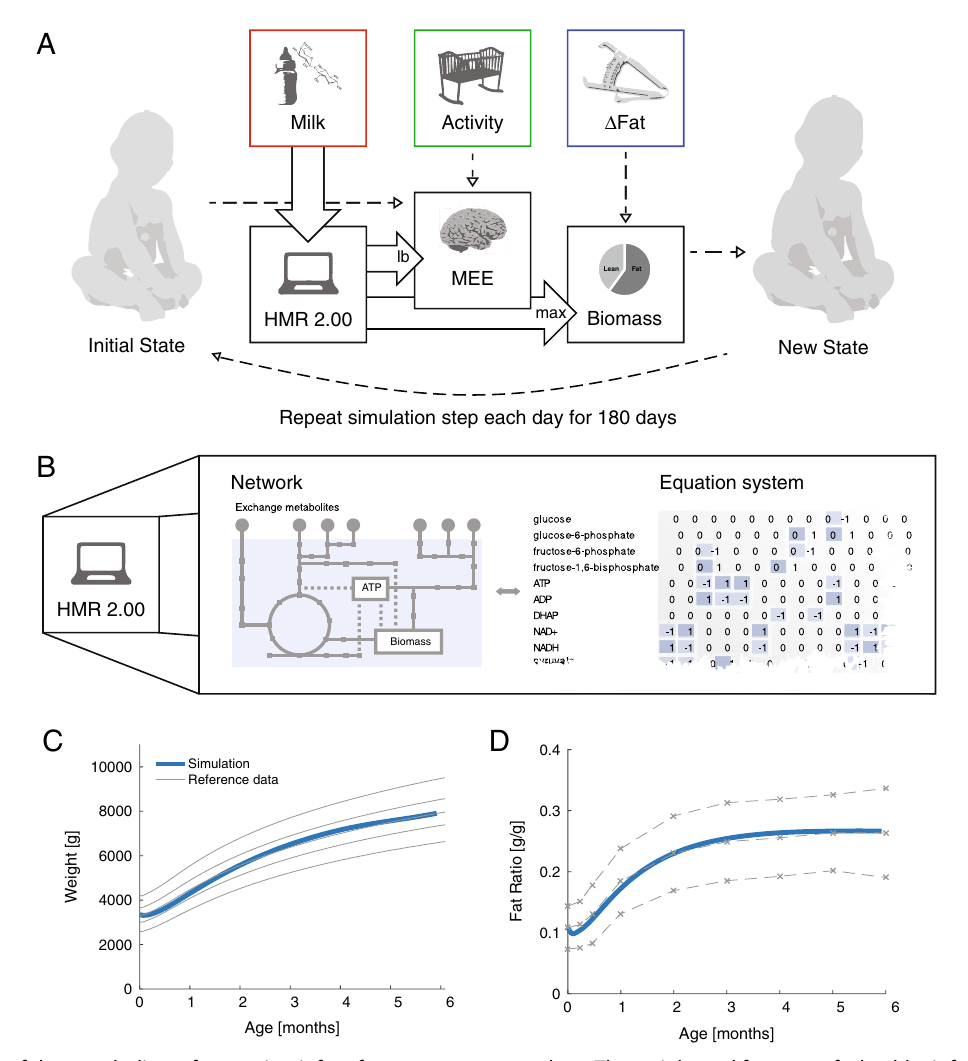
Fig. 1 Simulation of the metabolism of a growing infant from age 0 to 6 months. a The weight and fat mass of a healthy infant were chosen as the initial state of the simulation. Iterative simulations of the infant ’ s metabolism were performed, in which the current state was used as input to simulate the next state. The simulations were run in a human metabolic model (HMR 2.00) with the intake of metabolites from breast milk as uptake fl uxes. The maintenance energy expenditure was calculated from the current body composition, with an additional term for physical activity, which was a function of both age and weight. The objective of the simulation was set to maximize growth, after expending the maintenance energy. Growth was de fi ned as forming the biomass components (fat and lean mass), and the synthesizing energy required. The ratio of fat to total mass in the biomass composition was a function of age. b Simpli fi ed representation of the GEM (HMR 2.00) which contains 3800 Genes, 3000 unique metabolites and 8000 reactions out of which 1400 are cofactor dependent. c The weight increments from the simulation were expressed as a growth trajectory and compared with the 5th, 25th, 50th, 75th, and 95th percentile of WHO reference data. 3 d The ratio of fat mass to total mass at each time step, compared with the mean and two standard deviations, from a previous study